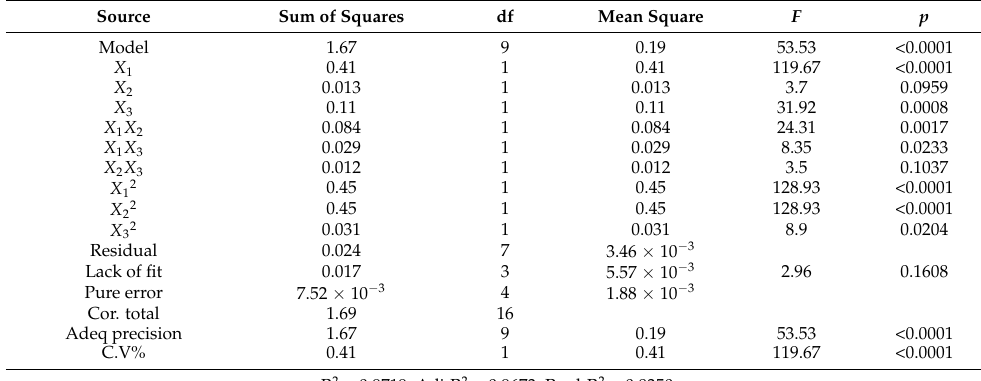
Table 2. ANOVA for the quadratic model.